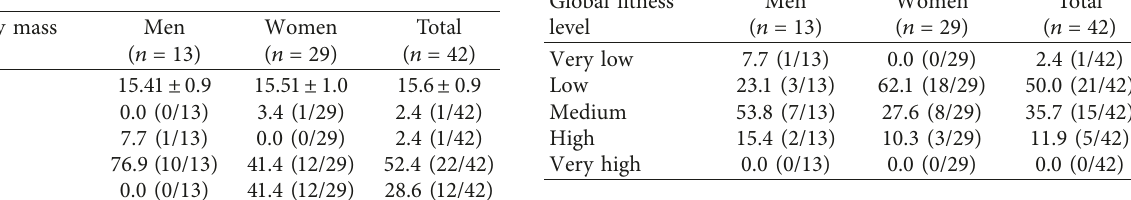
adolescents in the